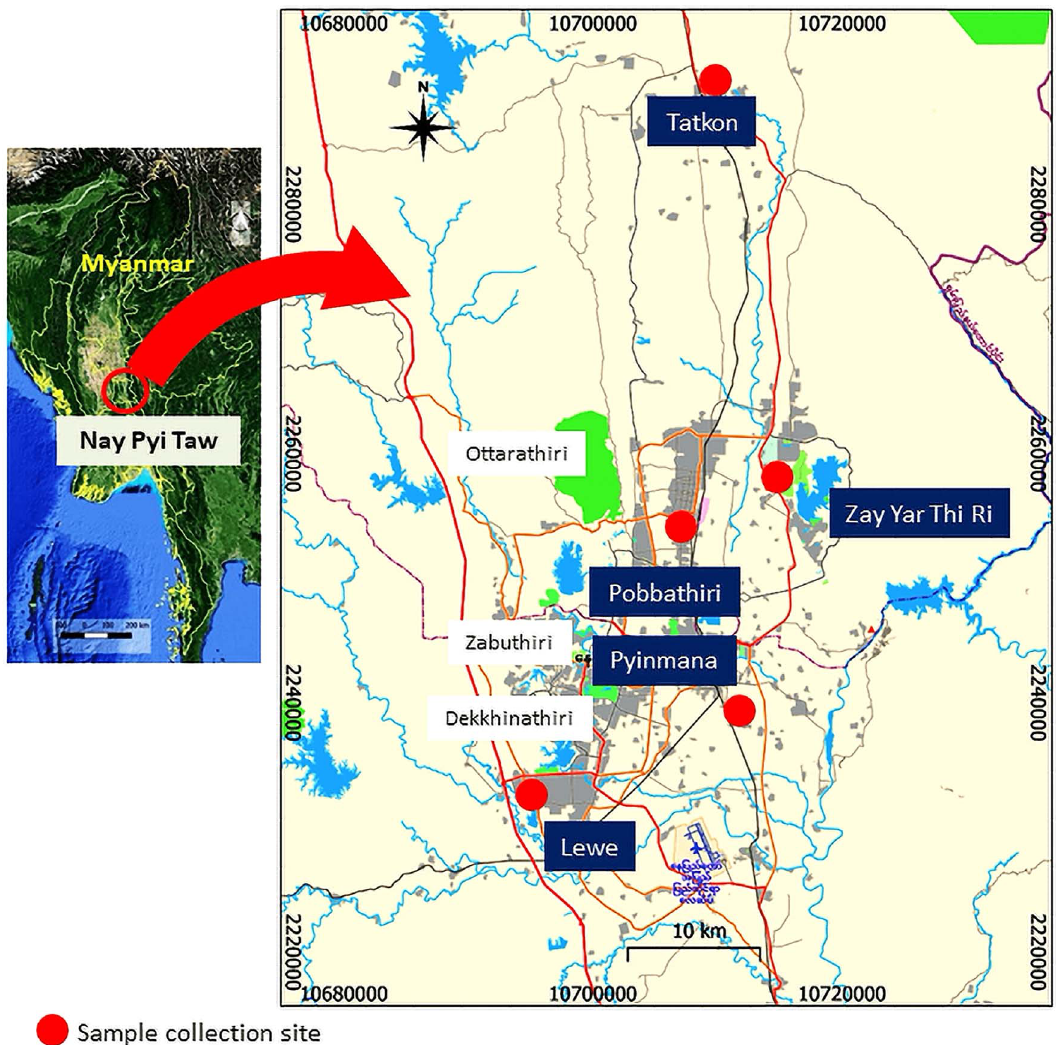
Figure 1. Map of Nay Pyi Taw showing sample collection locations.